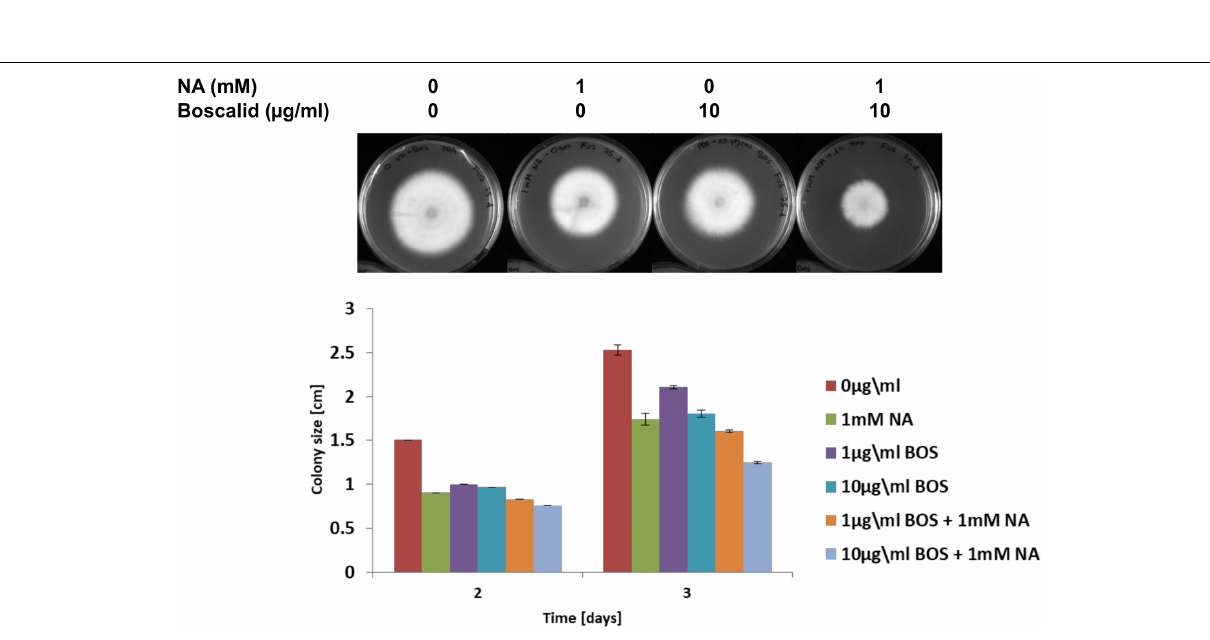
Frontiers in Microbiology |